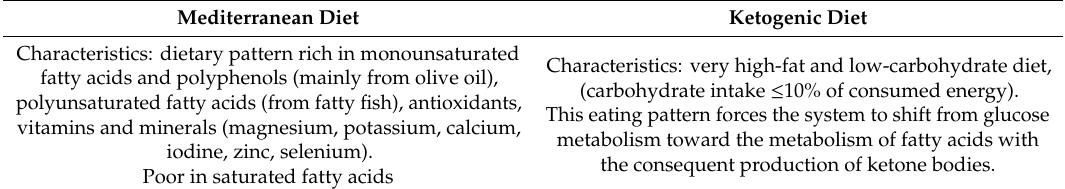
Characteristics: dietary pattern rich in monounsaturated fatty acids and polyphenols (mainly from olive oil), polyunsaturated fatty acids (from fatty fish), antioxidants, vitamins and minerals (magnesium, potassium, calcium, iodine, zinc, selenium). Poor in saturated fatty